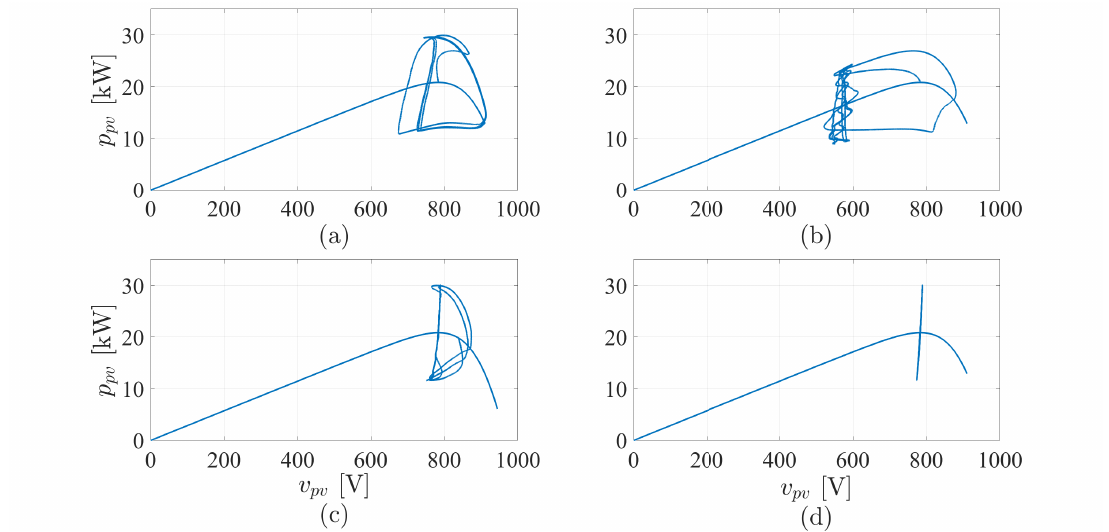
Figure 18. Power-voltage portraits of the PV system’s MPPT with sinusoidal radiation change: ( a ) P&O method; ( b ) modified P&O; ( c ) multi-power-sample method; ( d ) the proposed model-based